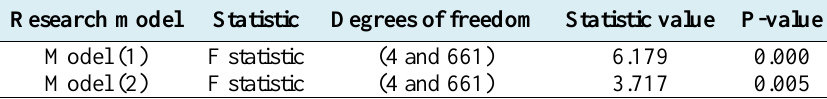
Table 4 . The results of the Breusch-Pagan-Godfrey testing of the TSE